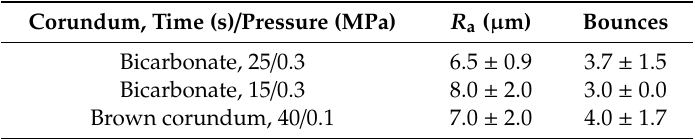
Table 4. Surface roughness ( R a ) and drop bounces for the sandblasted fluoropolymer coatings with lower tensile adhesion. In the first column, we show the corundum used, the blasting time and